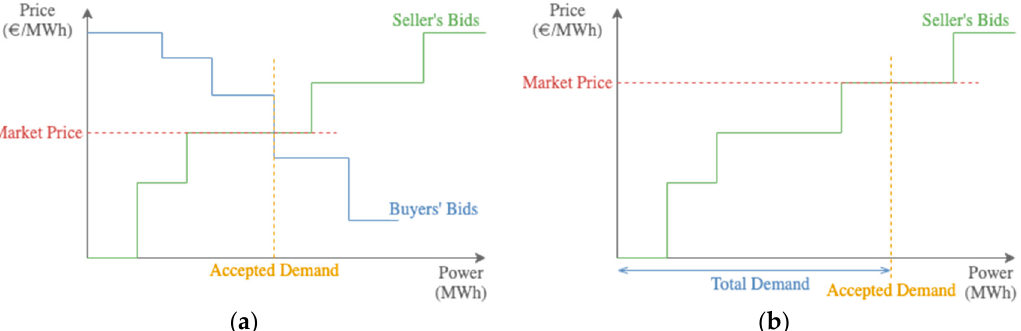
Figure 1. Common designs in auction-based electricity markets: ( a ) double auction or symmetric market pool; ( b ) single-sided auction or asymmetric market pool.